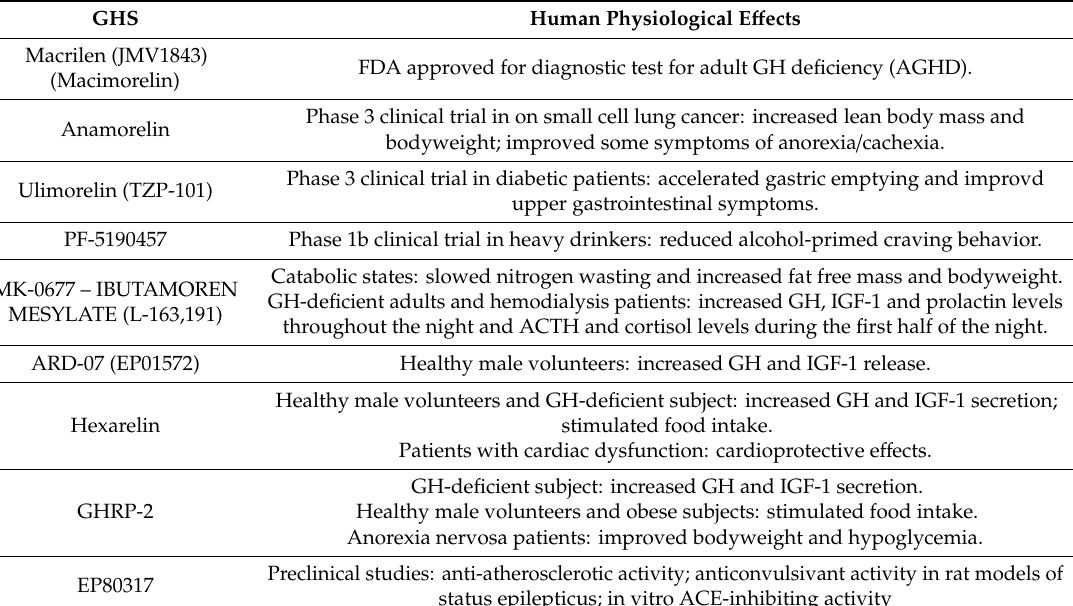
Table 1. GHS and human physiological e ff